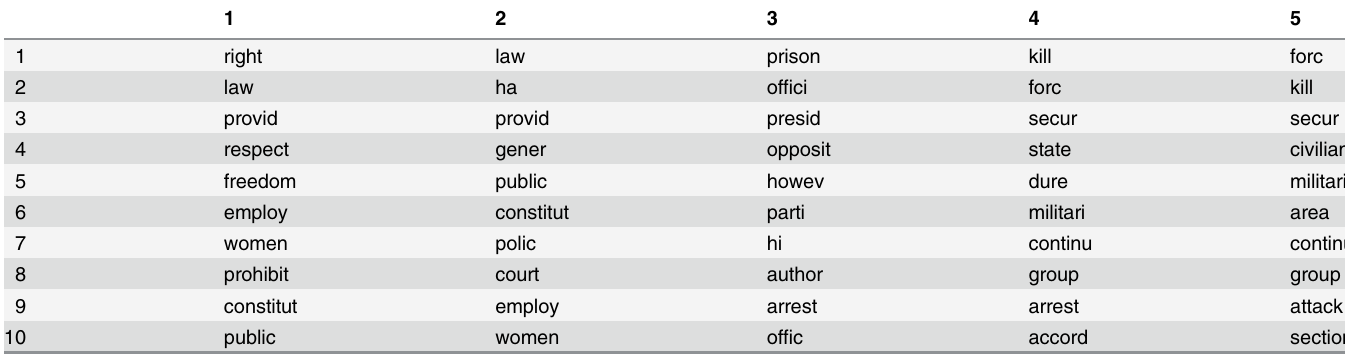
Table 2. Ten most important words for the PTS State Department variable.